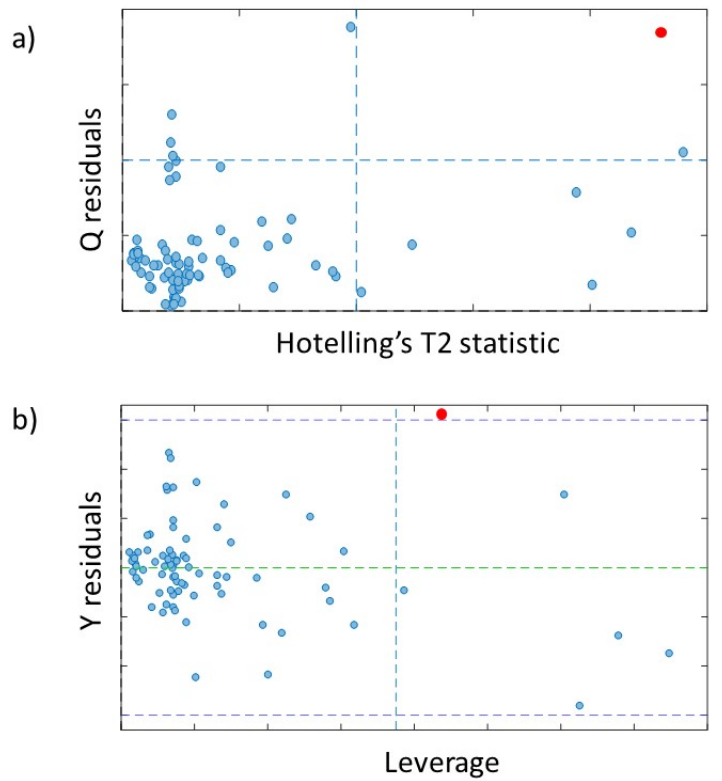
Figure 11. ( a ) Hotelling’s T 2 versus Q residuals plot and ( b ) Y_residuals versus leverage plot. One of the outlying samples is shown in red.